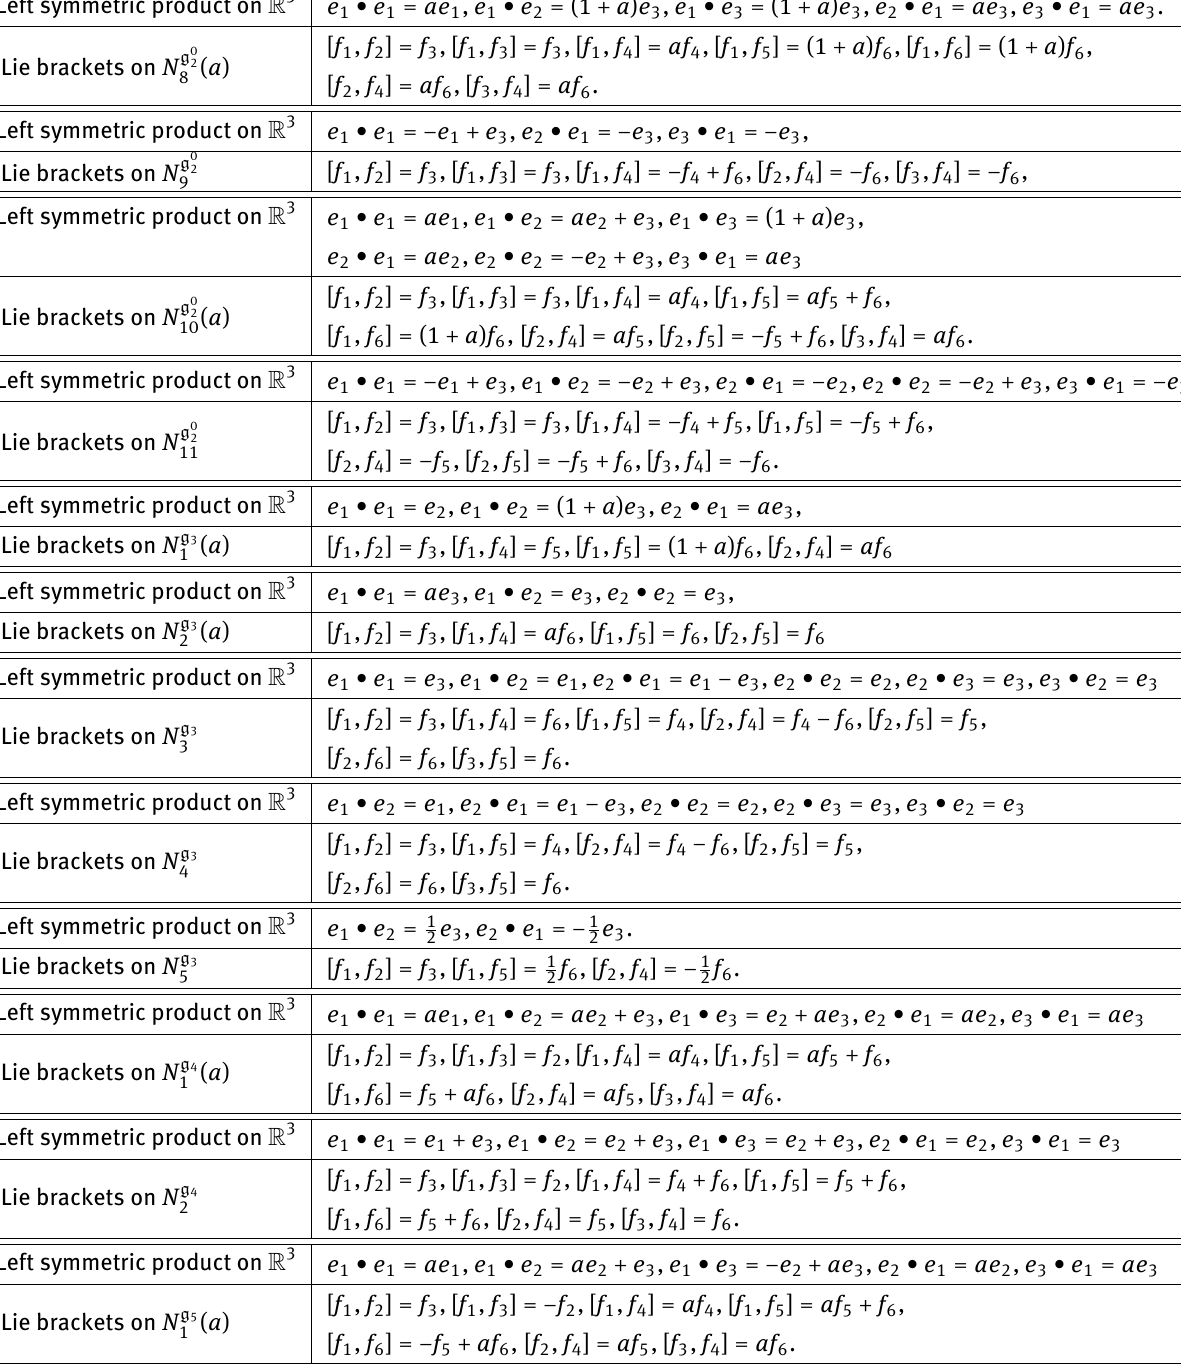
Table 2: Three dimensional Novikov algebras and their associated phase Lie algebras (Continued). Left symmetric product on R